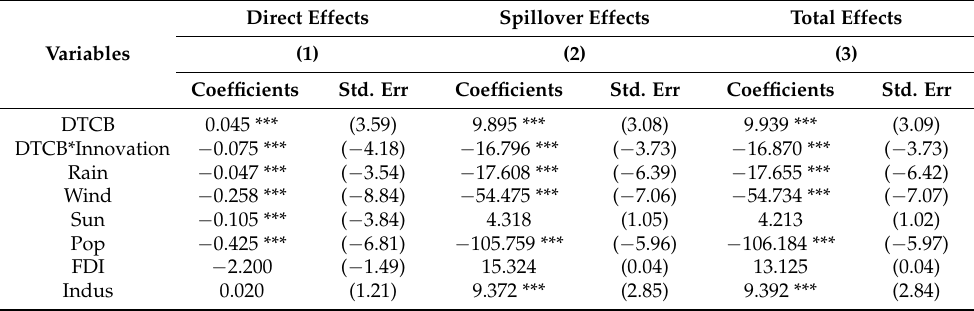
Table 11. Heterogeneity of the Degree of Development of the Digital